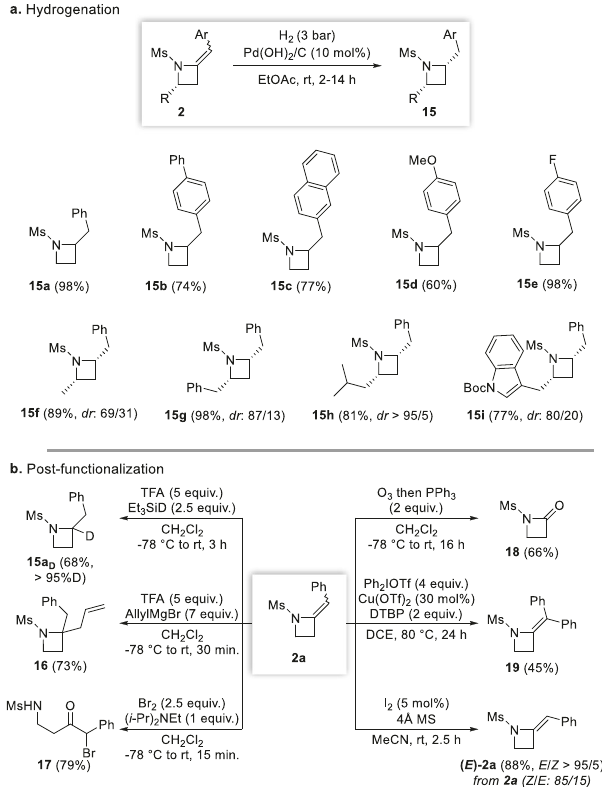
Fig. 6 Chemical diversi fi cation of representative unsaturated azetidines. a Hydrogenation of representative azetidines. b Post-functionalization of the exocyclic double bond of model azetidine 2a . Isolated yields are provided and dr were determined by 1 H NMR analyses of the crude reaction mixtures. TFA tri fl uoroacetic acid, DTBP 2,6-di- tert -butylpyridine and MS molecular